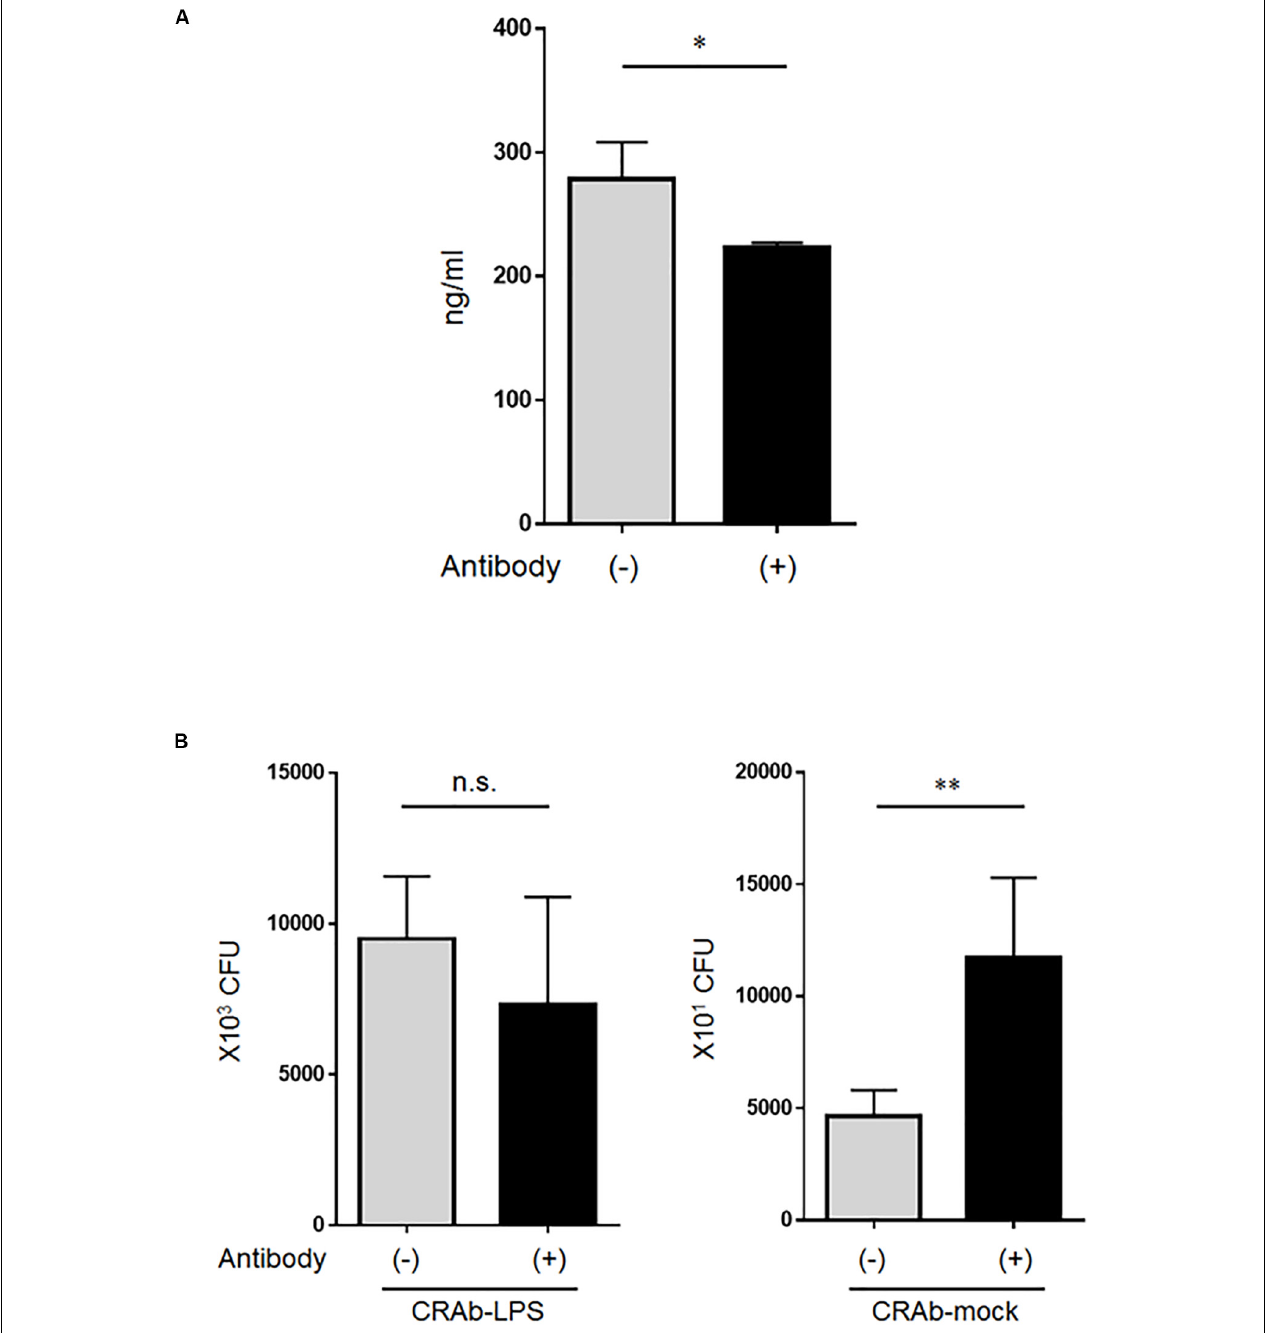
FIGURE 6 | Effect of lysozyme released by neutrophils on lipopolysaccharide-deficient Acinetobacter baumannii strains. (A) Neutrophilic lysozyme secreted into culture supernatants was measured by ELISA. Supernatants were obtained from neutrophils co-cultured with colistin-resistant A. baumannii for 4 h. Lysozymes were neutralized in other supernatants with anti-lysozyme antibody. Data are means ± SD; n = 4 per group. (B) Bacterial clearance experiments were performed using these supernatants. The supernatants were added to colistin-resistant A. baumannii (CRAb)-LPS or CRAb-mock and viable bacteria were counted by plating on kanamycin agar. Data are means ± SD; n = 6 per group. n.s., not significant, ∗∗ P < 0.01, ∗ P < 0.05. Means are representative of three